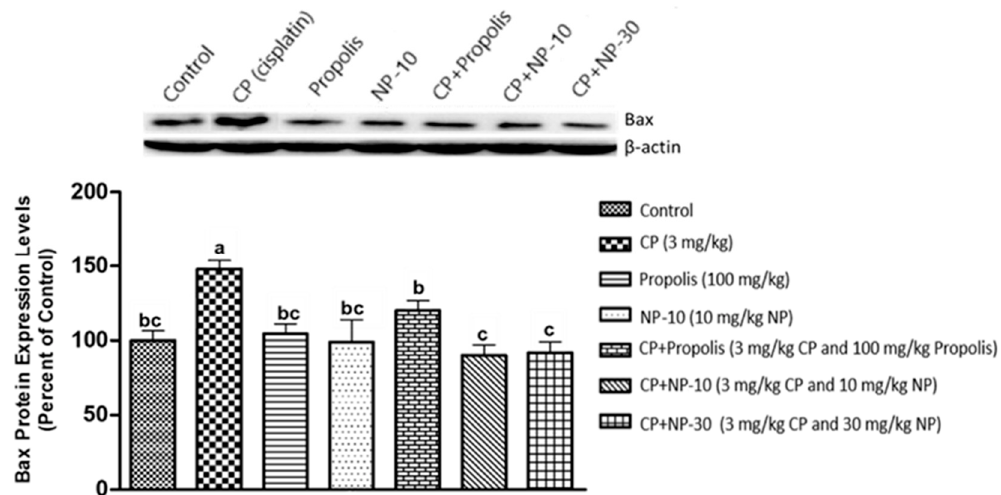
Figure 4. Bax protein expression levels in kidney tissue. a,b,c: Mean values within a row differ significantly, Significance is p < 0.001 (NP: nano-propolis).